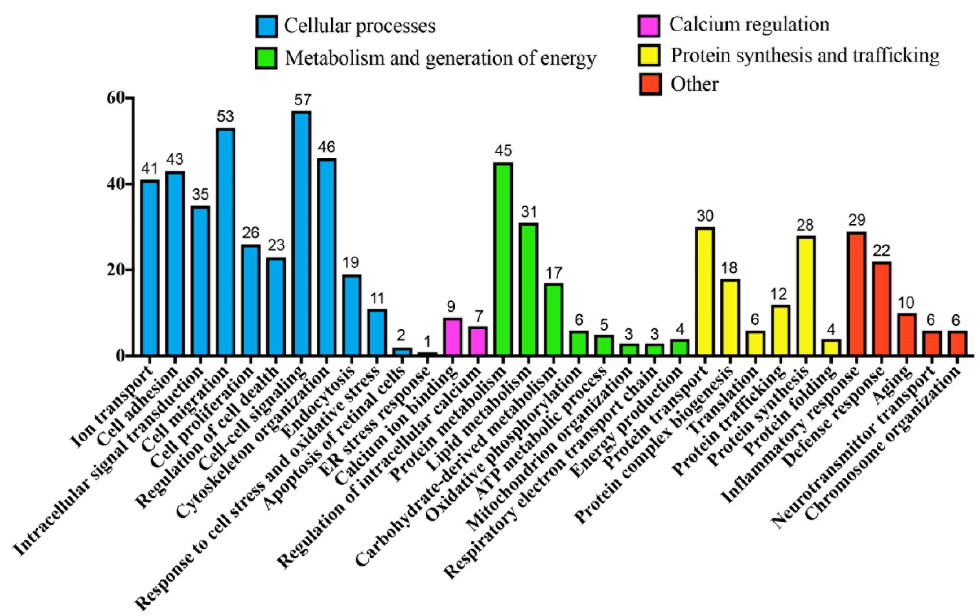
Figure 3. Hierarchical bar graph of key biological processes pertaining to significantly altered MAM proteins in Type 1 diabetic rat retinas. Biological processes of the 179 altered MAM proteins are classified as one of four categories of cellular activities or “other” according to GO analysis. MAM: Mitochondria-associated ER membrane, GO: Gene ontology.